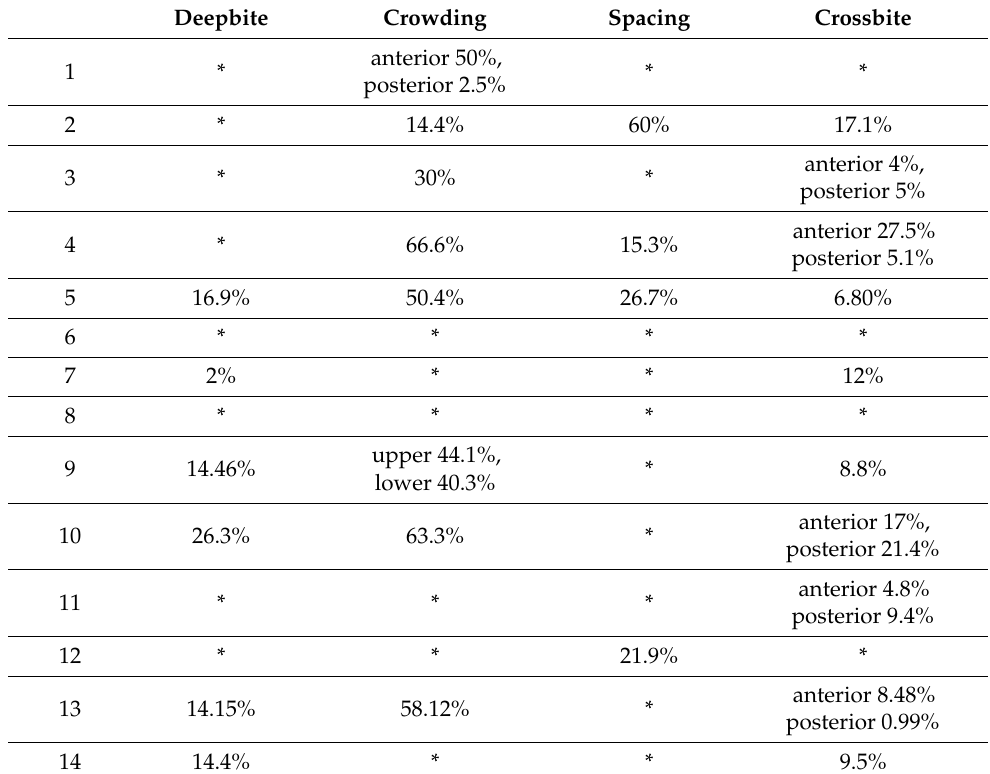
Table 3. Deepbite, crowding, spacing, crossbite prevalence for each study. (* the anomaly considered was not